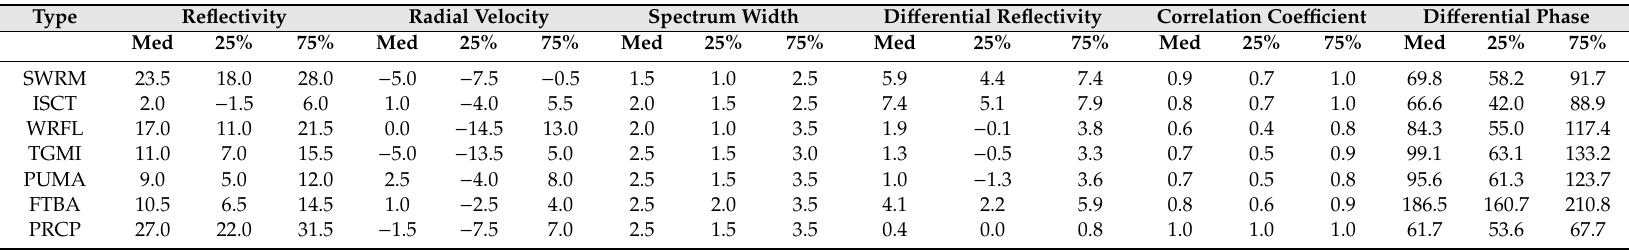
Table A2. Median, 25th and 75th percentiles of each radar parameter for each class (excluding EAGR). Values correspond to distributions in Figure